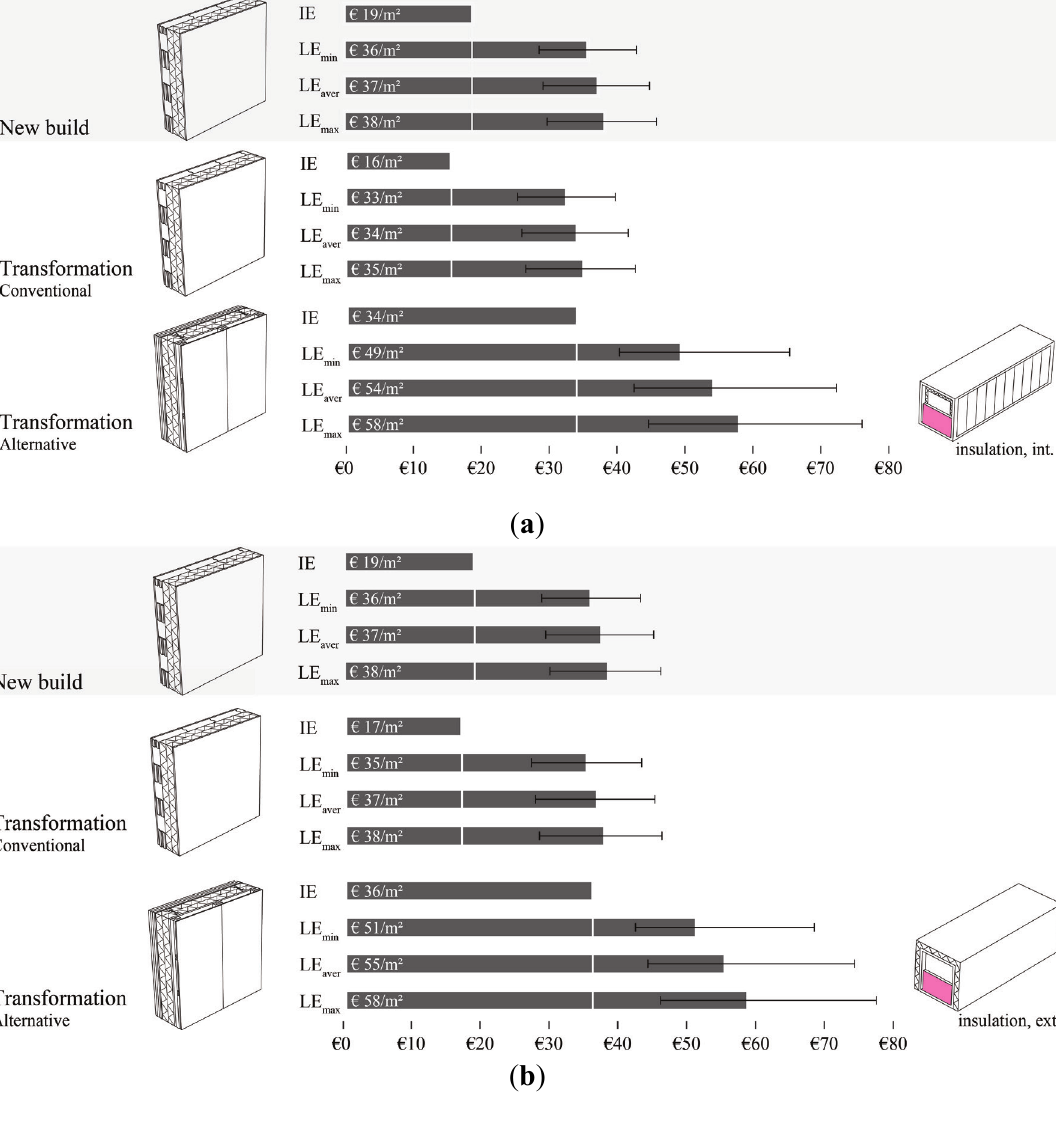
Figure 6. Based on the outcomes of the life cycle assessments of the external wall, with ( a ) internal or ( b ) external wall insulation, the conclusions are similar for both cases: transformation with conventional elements has the lowest impact. With IE as initial environmental impact, LE min as life cycle impact with no refurbishments, LE aver as life cycle impact with an average number of refurbishments, LE max as life cycle impact with a maximum number of refurbishments during 60 years, the error bars represent the results of the sensitivity analysis on a variable lifespan of the building (from 30 to 79